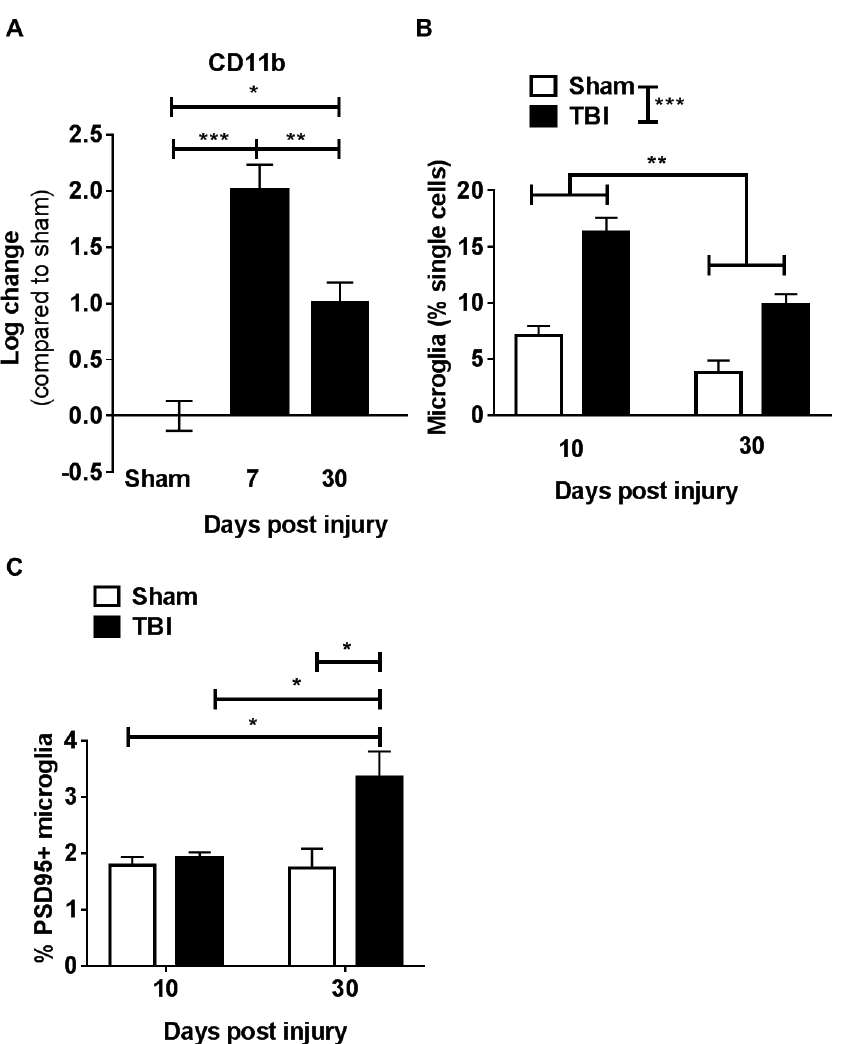
Figure 3. Increased microglia numbers and phagocytic activity chronically after contusion injury. ( A ) Cluster of differentiation 11b (CD11b) gene-expression changes in the hippocampus of aged animals were measured by qPCR analysis, comparing expression levels between sham uninjured animals, and those 7 and 30 days post injury. CD11b, a marker for microglia and macrophages, significantly increases post injury. One-way ANOVA revealed significant differences (F = 21.12; p < 0.0001). Tukey post hoc test revealed differences between groups; n = 4–6/group ( B ) Brain microglia composition increases at 10 and 30 days post injury. Flow cytometry result revealed that percentage of microglia in the brain significantly increased at both 10 and 30 days after traumatic brain injury (TBI). Two-way ANOVA revealed significant effects of time (F(1,8) = 21.93, p < 0.01) and injury (F(1,8) = 53.59, p < 0.0001) without significant interaction (F(1,8) = 2.341, p = 0.1645). ( C ) Changes in synaptosomes (containing post-synaptic density protein PSD95) phagocytosis by microglia. There was no change in microglia phagocytosis activity at 10 days after TBI. However, at 30 days after TBI, there was a significant increase of exogenous synaptosome phagocytosis activity in microglia. Two-way ANOVA revealed significant differences in the effects of time (F = 5.333, p < 0.05) and injury (F = 8.456, p < 0.05), with significant interaction (F = 6.111, p < 0.05). Bars depict group means and SEM; * p < 0.05, ** p < 0.01, *** p < 0.0001.